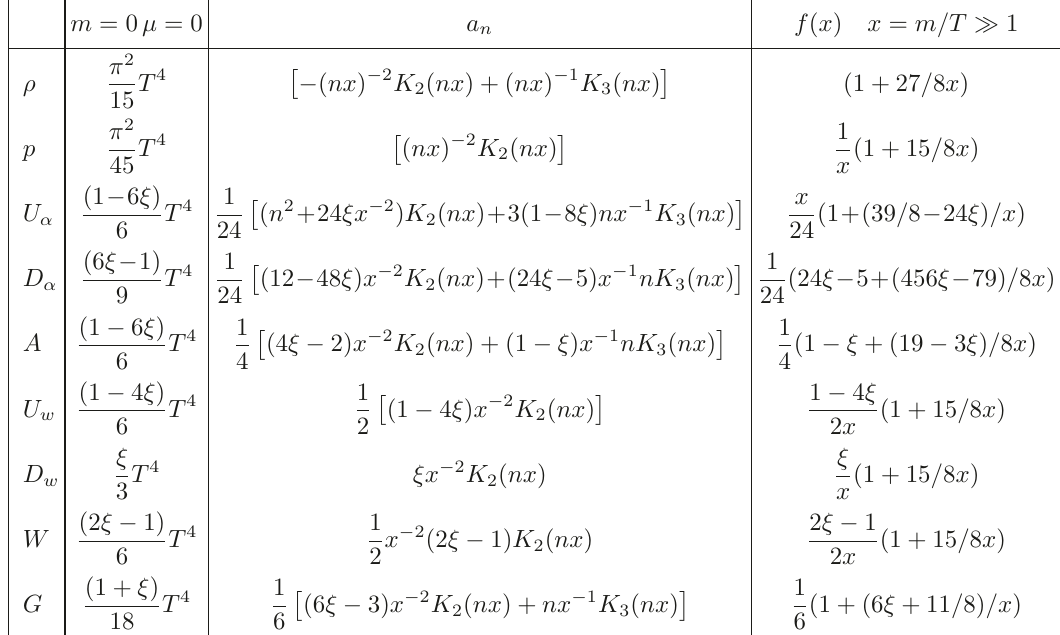
Table 1 . The stress-energy tensor coefficients (5.3) for a free Boson field: the first column reports the coefficients in the massless case with µ = 0, the second column reports the n th term of the expansion (8.2), the third column reports the asymptotic expansion at low temperature (8.3). Our result for W in the massless case agrees with that obtained in ref. [29] for λ 3 (see eq.